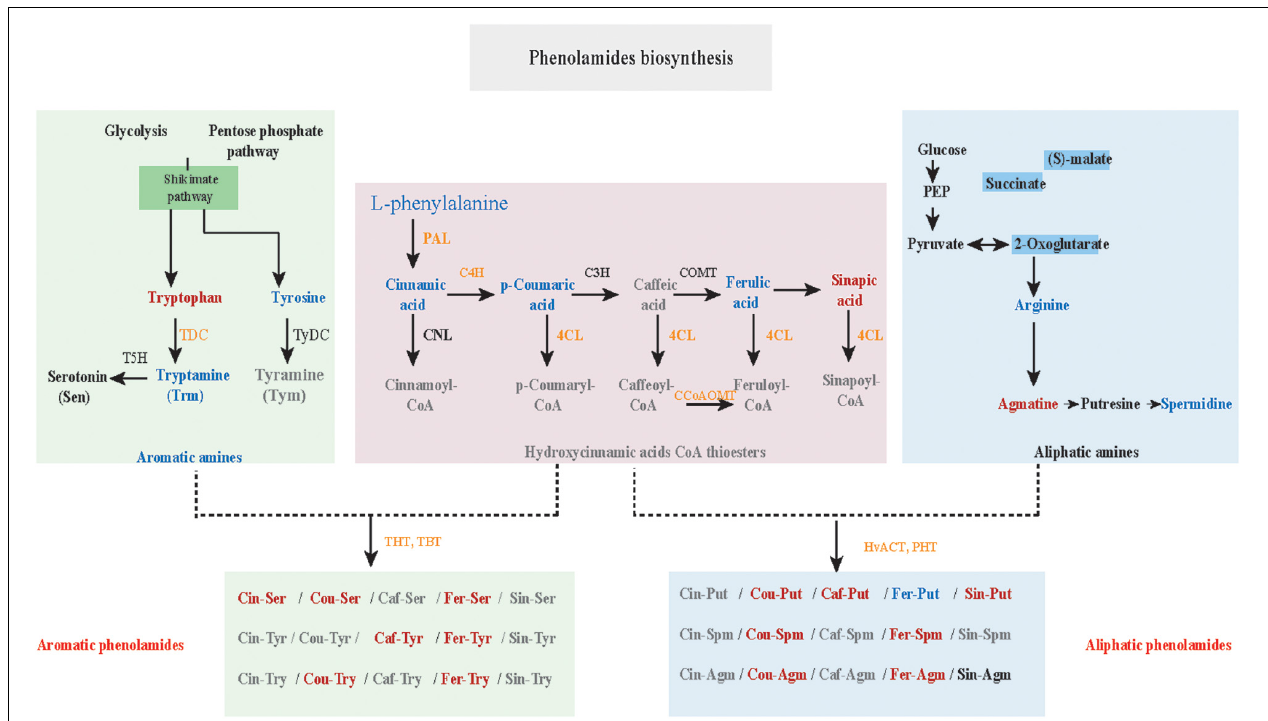
FIGURE 4 | Differently expressed genes (DEGs) and accumulated metabolites (DAMs) from the pathway of phenolamides (PAs) biosynthesis in K69 and G72 lines of qingke during powdery mildew infection. The orange or green capital letters represented the significant up-regulated or down-regulated genes in K69 when compared to the G72 line. The expression level of these DEGs and the corresponding full gene name were listed in Supplementary Table 9 . Red or blue lower case indicated markedly accumulated or reduced metabolites between the K69 and the G72 qingke line under powdery mildew stress.